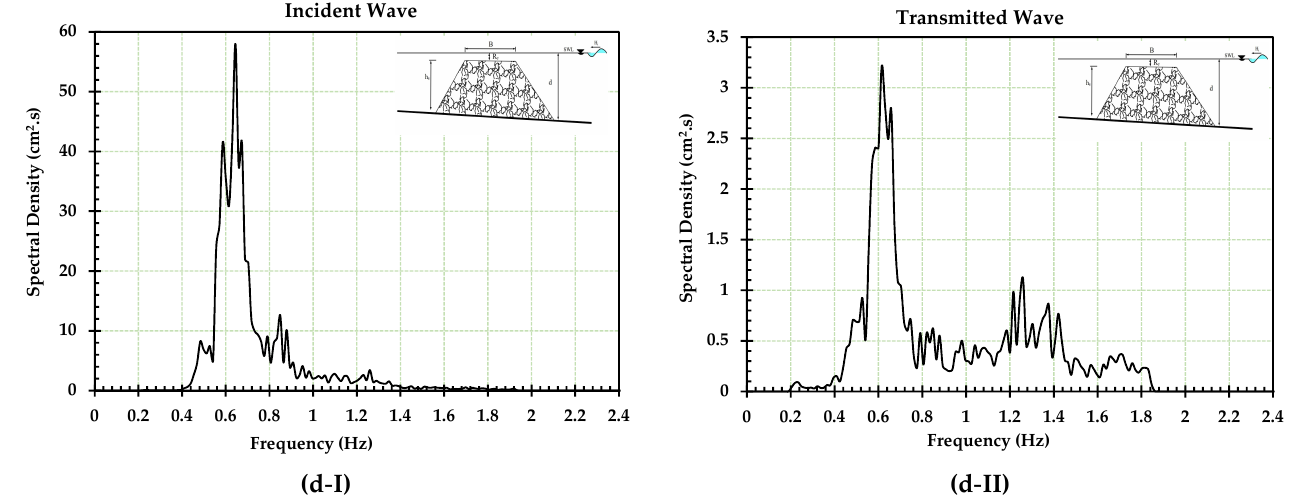
Figure 11. Examples of the incident and transmitted wave spectra for breakwaters: emerged ( a ); zero-freeboard ( b ); and submerged ( c ) and ( d ).